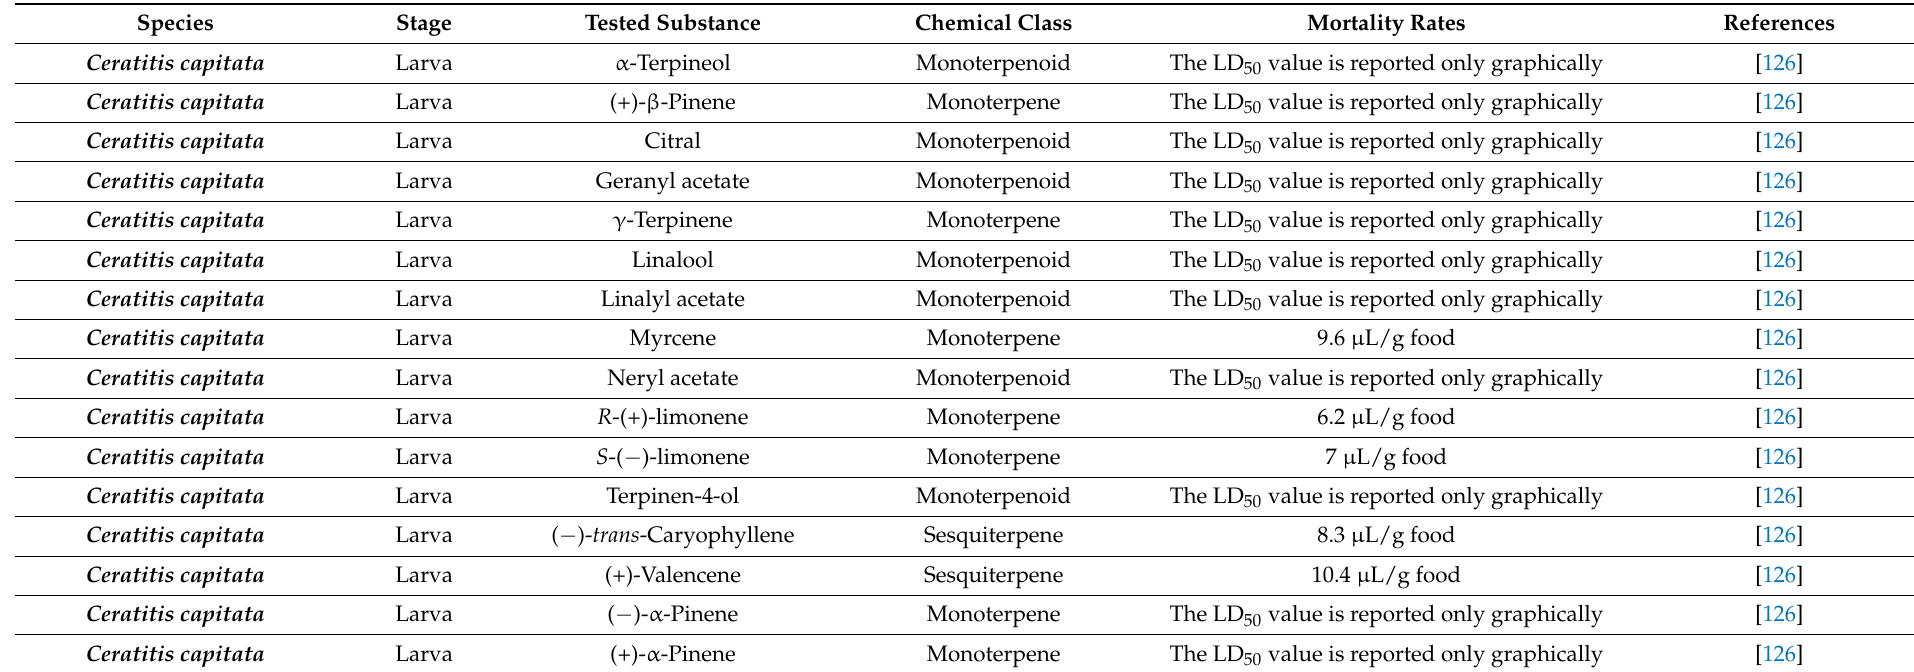
Table 7. Terpenoids and phenylpropanoids were examined for ingestion action against immature and adult stages of Tephritidae